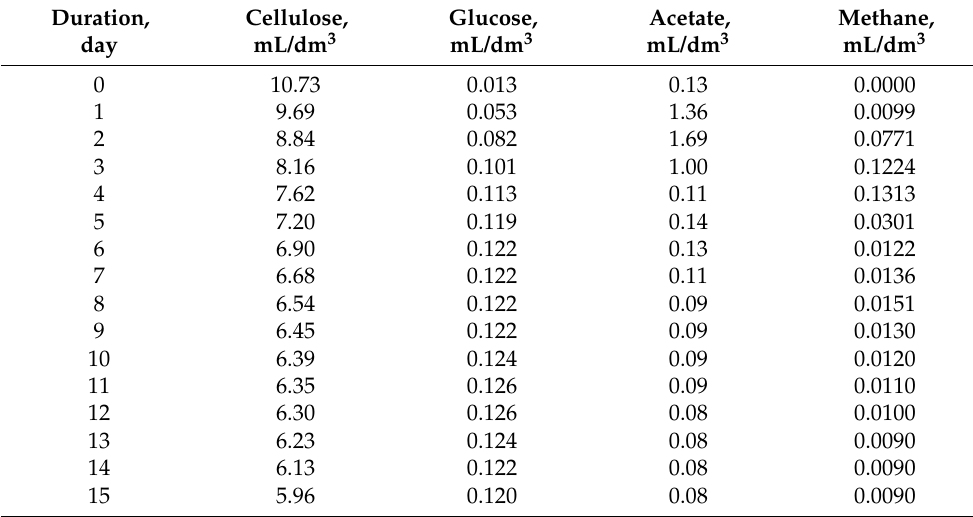
Table 1. Batch experiments with 30 mL/dm 3 organic